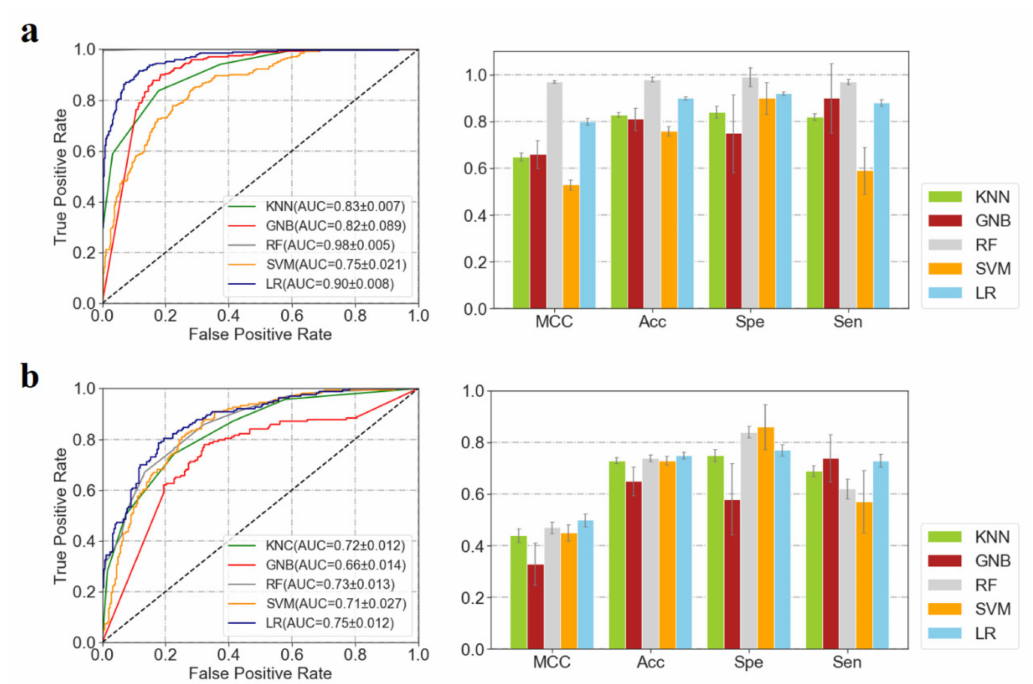
Figure 4. The performances of the 5 ML models on the training ( a ) and validation dataset ( b ). (SVM model: a radial basis function (RBF) kernel was used, of which the C and γ were set as 1 and ‘auto’, respectively; LR model: the inverse of regularization strength, tolerance for stopping criteria, maximum number of iterations, and penalty were set as 0.5, 0.001, 200, and “L1”, respectively. Herein, default parameters were used for the ML models if not specified.)